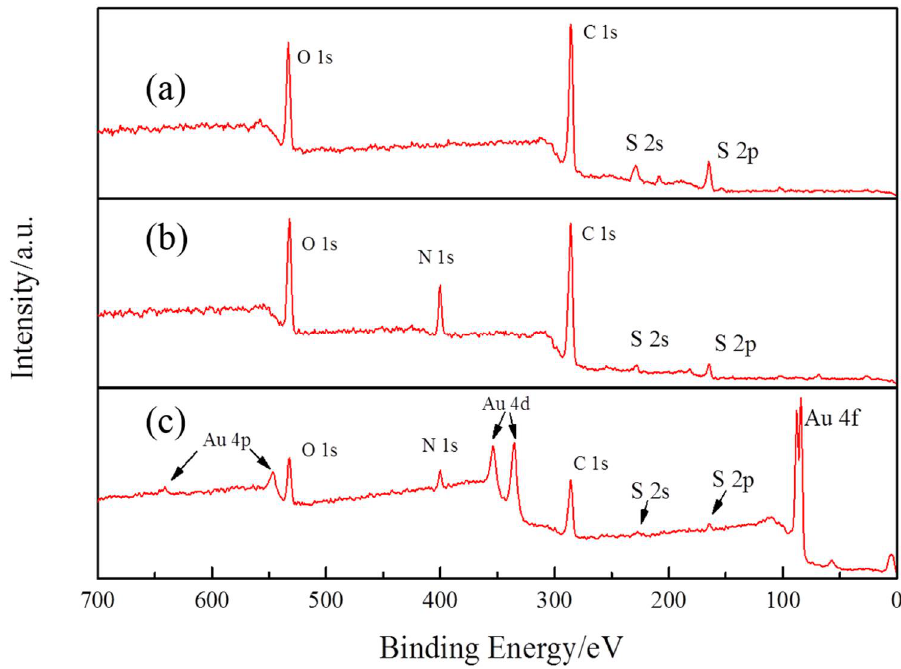
Figure 6. The overall XPS spectra of electrodes: (a) PEDOT/Pt, (b) PEDOT:BSA/Pt, and (c) AuNPs/PEDOT:BSA/Pt.